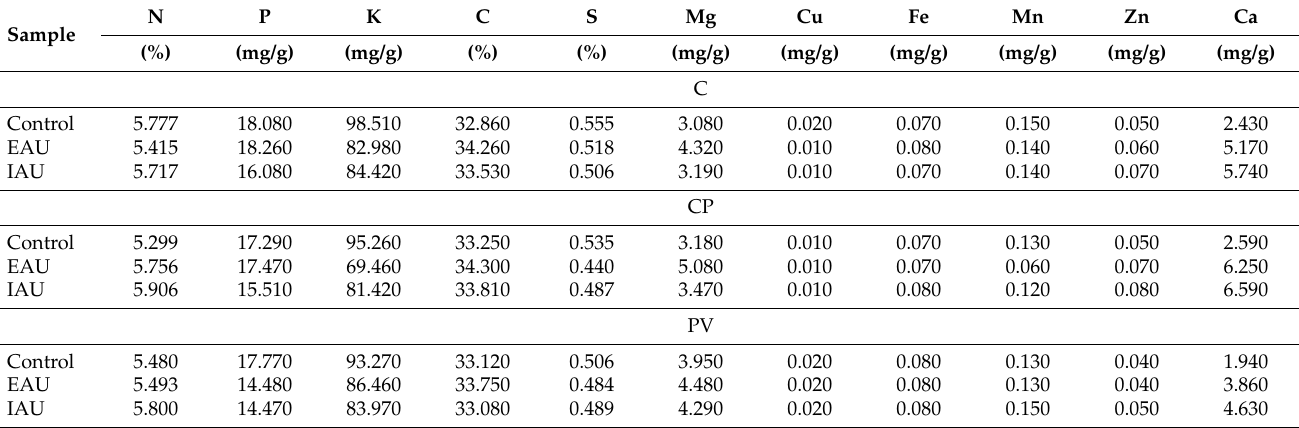
Table 9. Wheatgrass macro- and micronutrient contents in different experimental groups (“Control”— fertilized tap water; “IAU”—fish effluents from intensive aquaculture unit; “EAU”—fish effluents from extensive aquaculture unit; “C”—100% coconut fibers; “CP”—70% coconut fibers + 30% perlite; “PV”—50% vermiculite + 50% perlite).